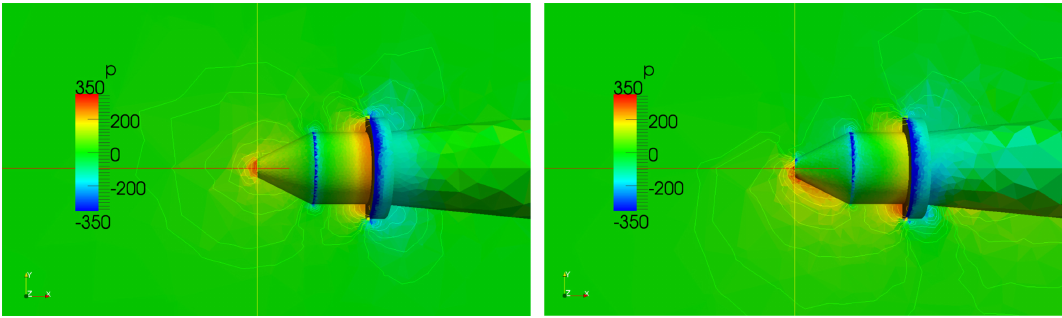
Fig. 3. OpenFOAM flow simulation around the probe tip at 24m s − 1 total airspeed at 0 ◦ angle of sideslip in both figures, 0 ◦ angle of attack in the left figure and 10 ◦ angle of attack in the right figure. The colour scale shows differential pressure to the environment in pascals.